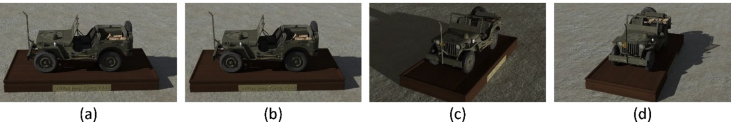
Sample of rendered images of the Jeep model. (a) image from the ‘fs’ set. (b) image from the ‘fs-dof-mb’ set. (c, d) images from the ‘ms’ set.